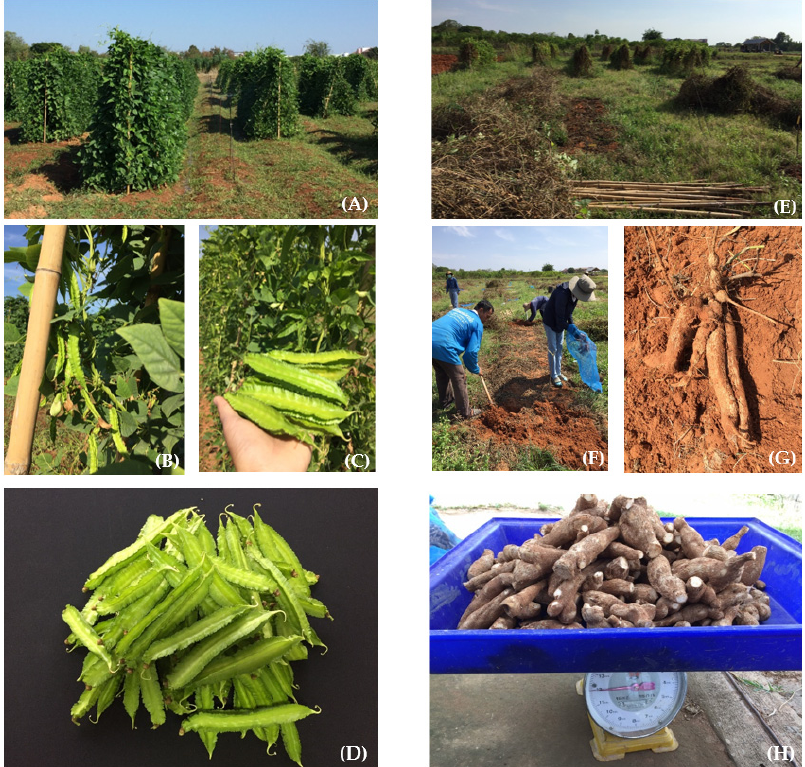
Figure 1. Dual-purpose of the winged bean ( Psophocarpus tetragonolobus (L.) DC.) based on pod yield ( A – D ) and tuber yield ( E – H ).